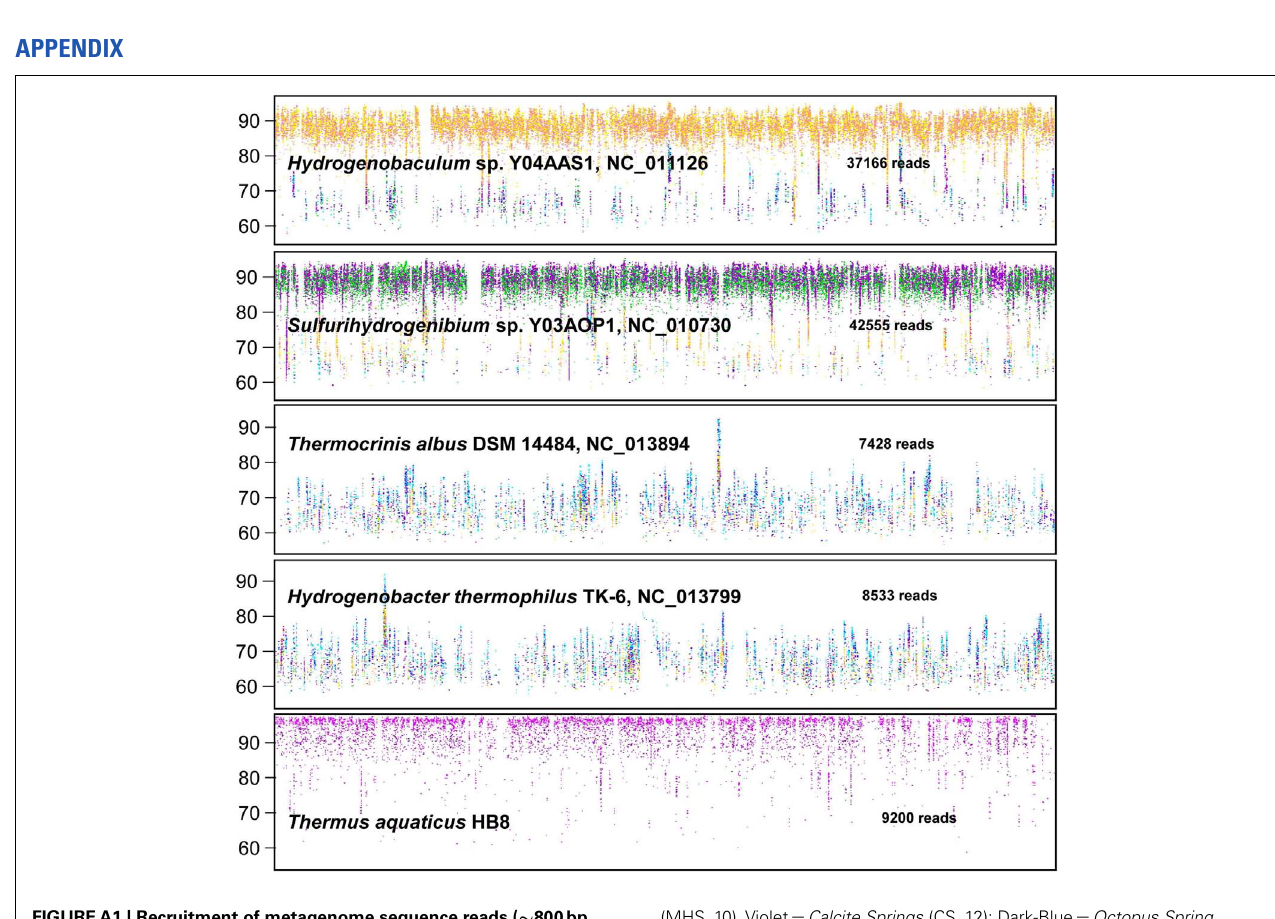
(MHS_10),Violet = Calcite Springs (CS_12); Dark-Blue = Octopus Spring (OS_11), light-blue = Bechler Springs (BCH_13). Reference genomes: